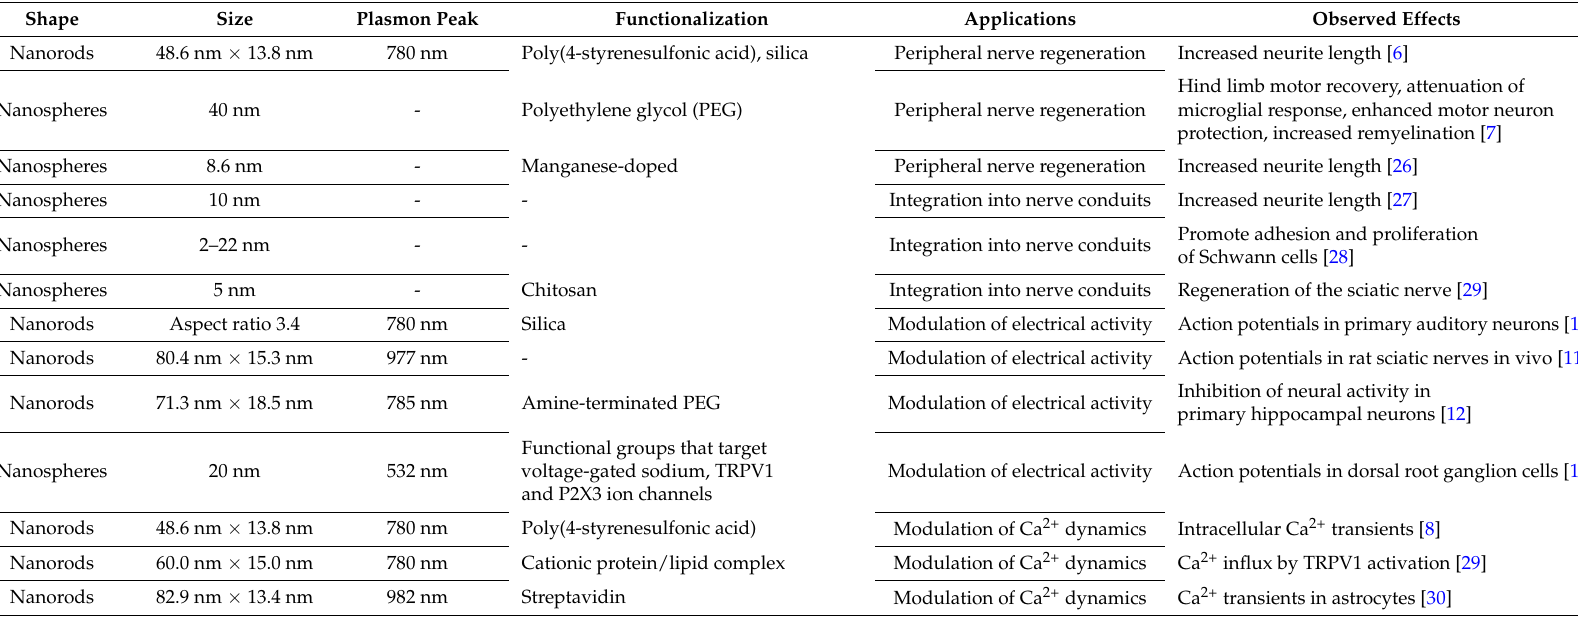
Table 1. Summary of Au NP characteristics for modulation of neural activity. Plasmon peaks have only been indicated when relevant to the study.